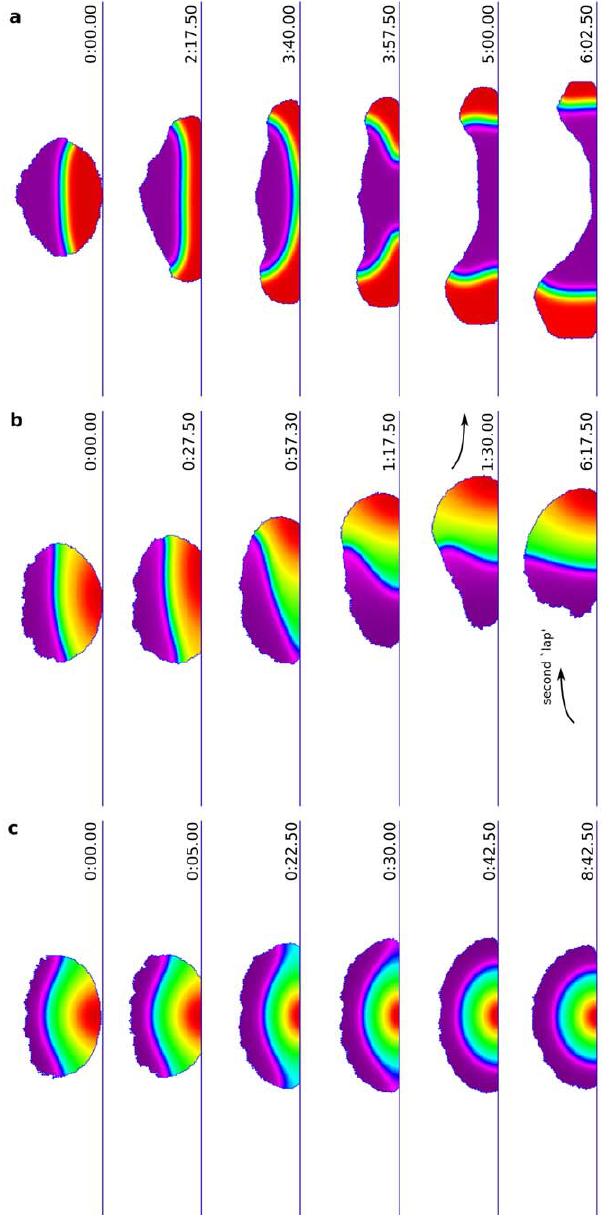
Figure 7. Response of cells with varying degree of PI feedback to a wall. Cells initially polarized and moving rightwards encounter a wall (blue vertical band). ( a ) without feedback from PIs ( f ~ 0 ) the cell has difficulty resolving the competition between two nascent ‘‘fronts’’; ( b ) with the standard intermediate feedback from PIs ( f ~ 0 : 4 ) the cell is able to make a decision and move smoothly along the wall; ( c ) with extreme feedback from PIs ( f ~ 1 ) the leading edge becomes confined and encircled by the contracting back, so that the cell becomes stuck. (See also Video S9.)